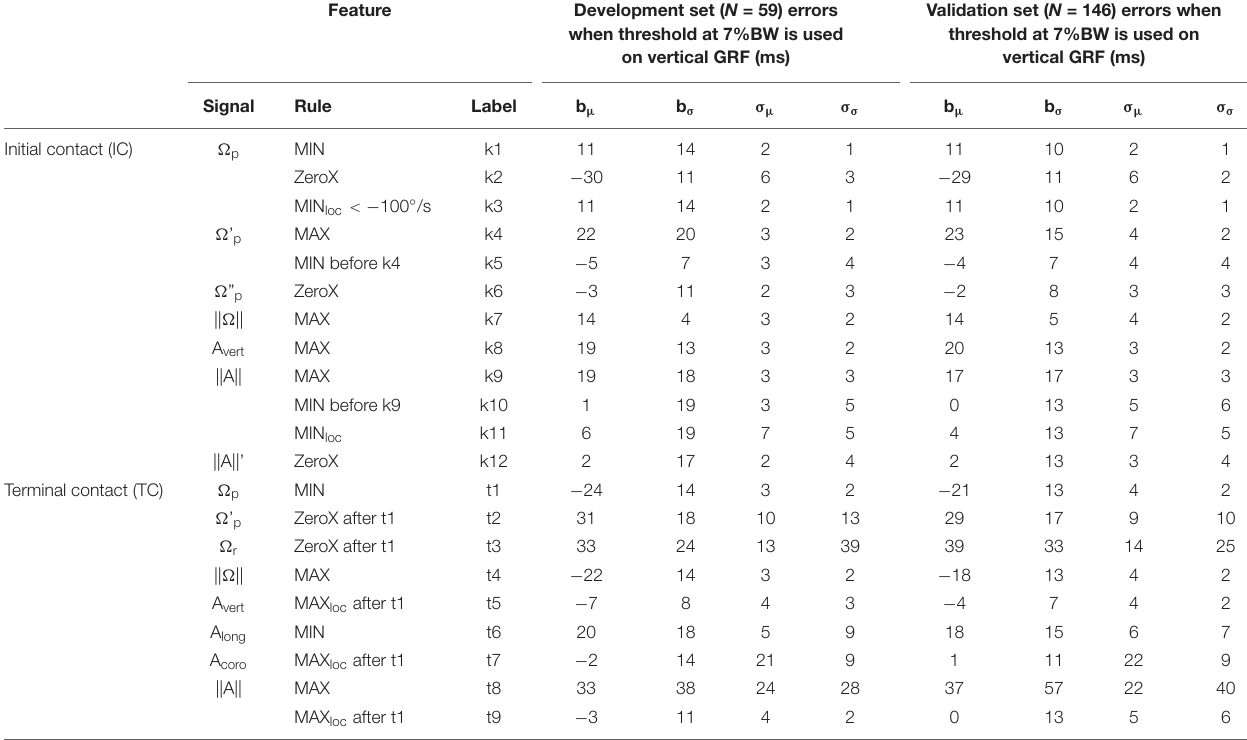
TABLE 2 | List of time differences for all the IC and TO candidates, computed over 4836 and 12092 steps for the development set and the validation set, respectively. Feature Development set ( N = 59) errors Validation set ( N = 146) errors when when threshold at 7%BW is used threshold at 7%BW is used on